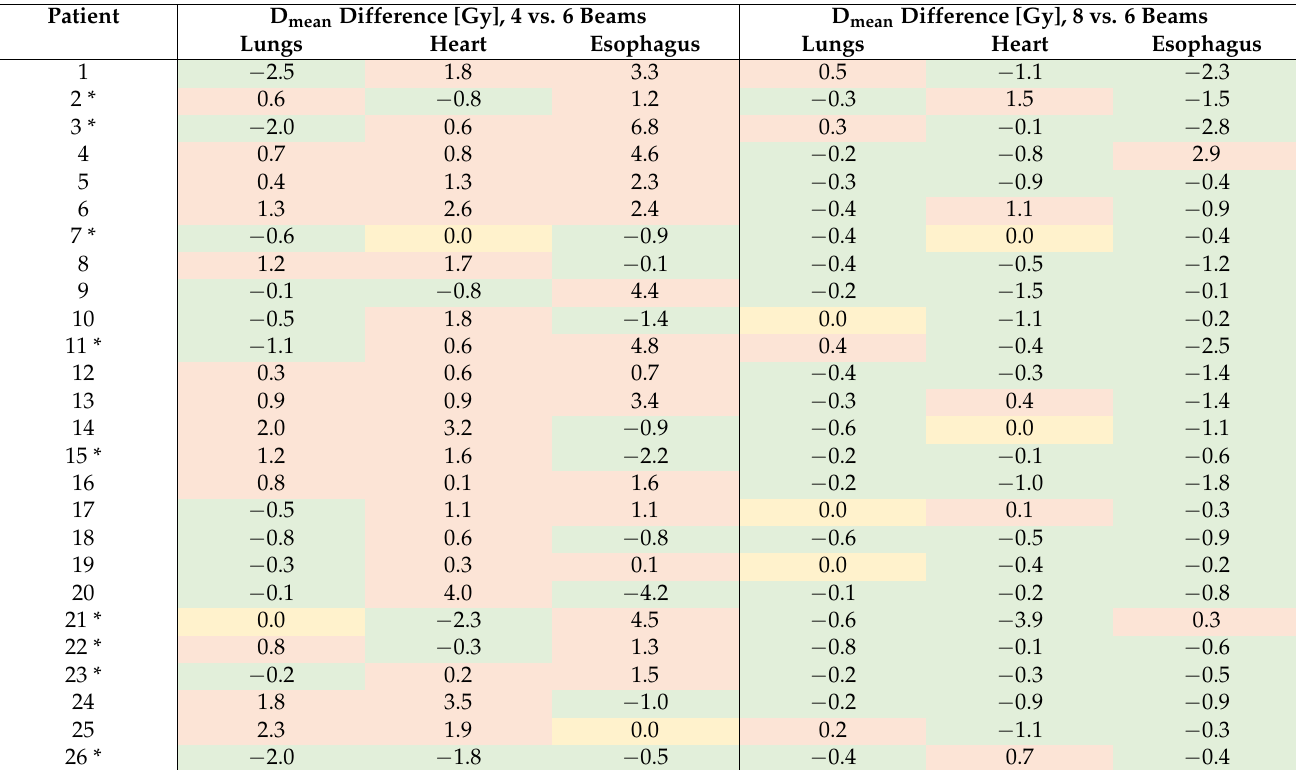
Table A1. Difference per patient in D mean for OARs in 4- and 8-beam iCE plans compared to 6-beam iCE plans, all with optimized beam angles. The colors indicate if the dose was increased (red), reduced (green) or equal (yellow) compared to the 6-beam plan. For patients marked with *, the D max requirement for the spinal canal or patient body was not met in the 4-beam plan